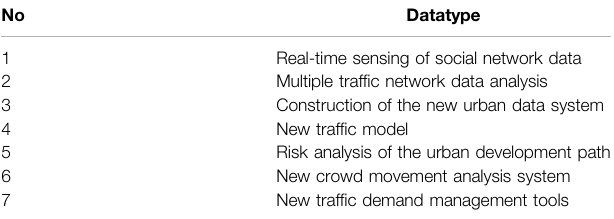
TABLE 1 | New data environment for urban space and crowd activity analysis.